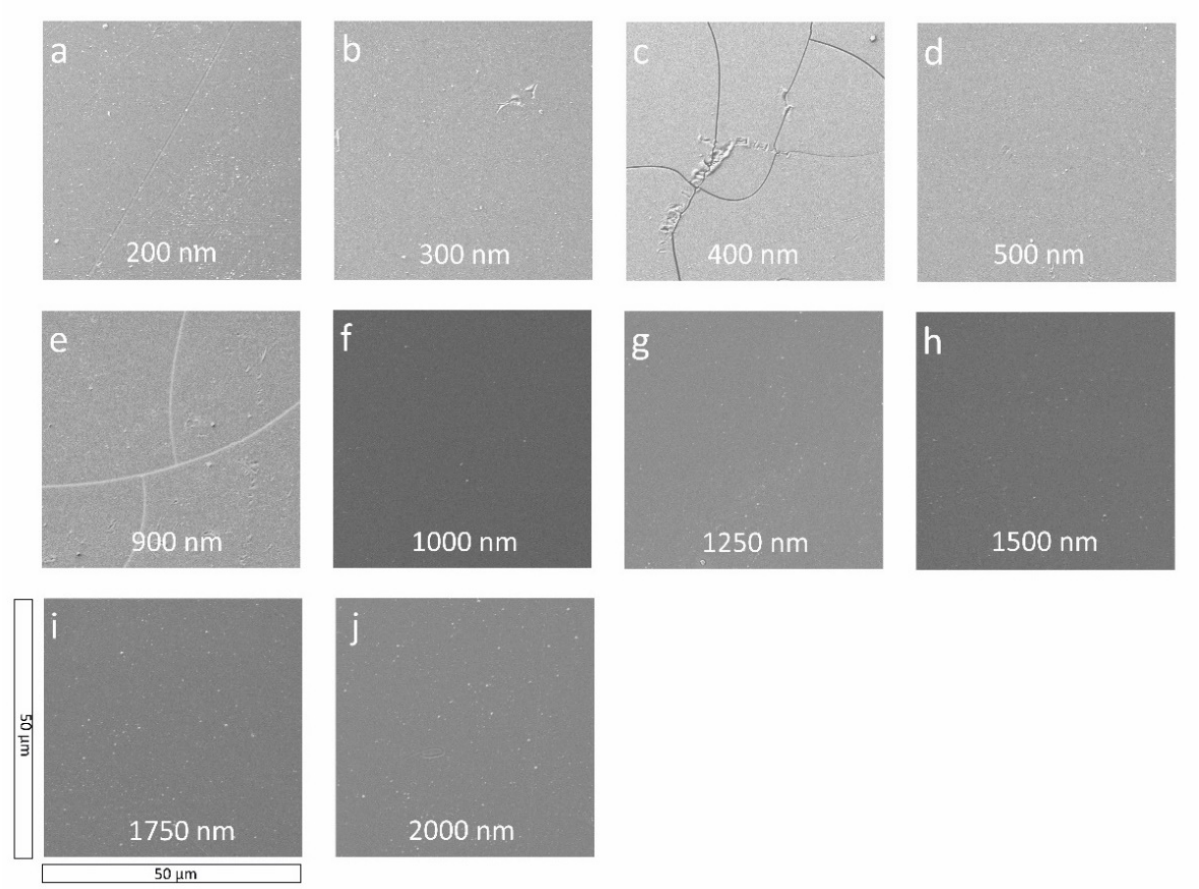
Figure 2. SEM results for thick a-C:H layers deposited on PC. Shown are the film thicknesses of 200 nm ( a ) to 2000 nm ( j ).